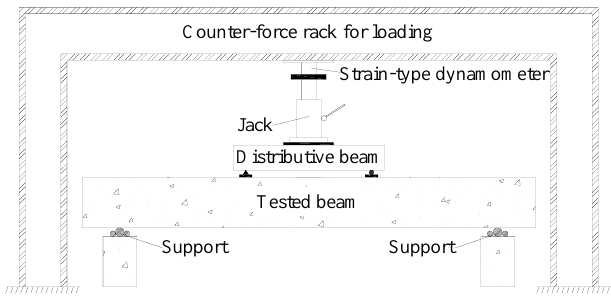
Figure 5. Layout of the "4-point" bending test.